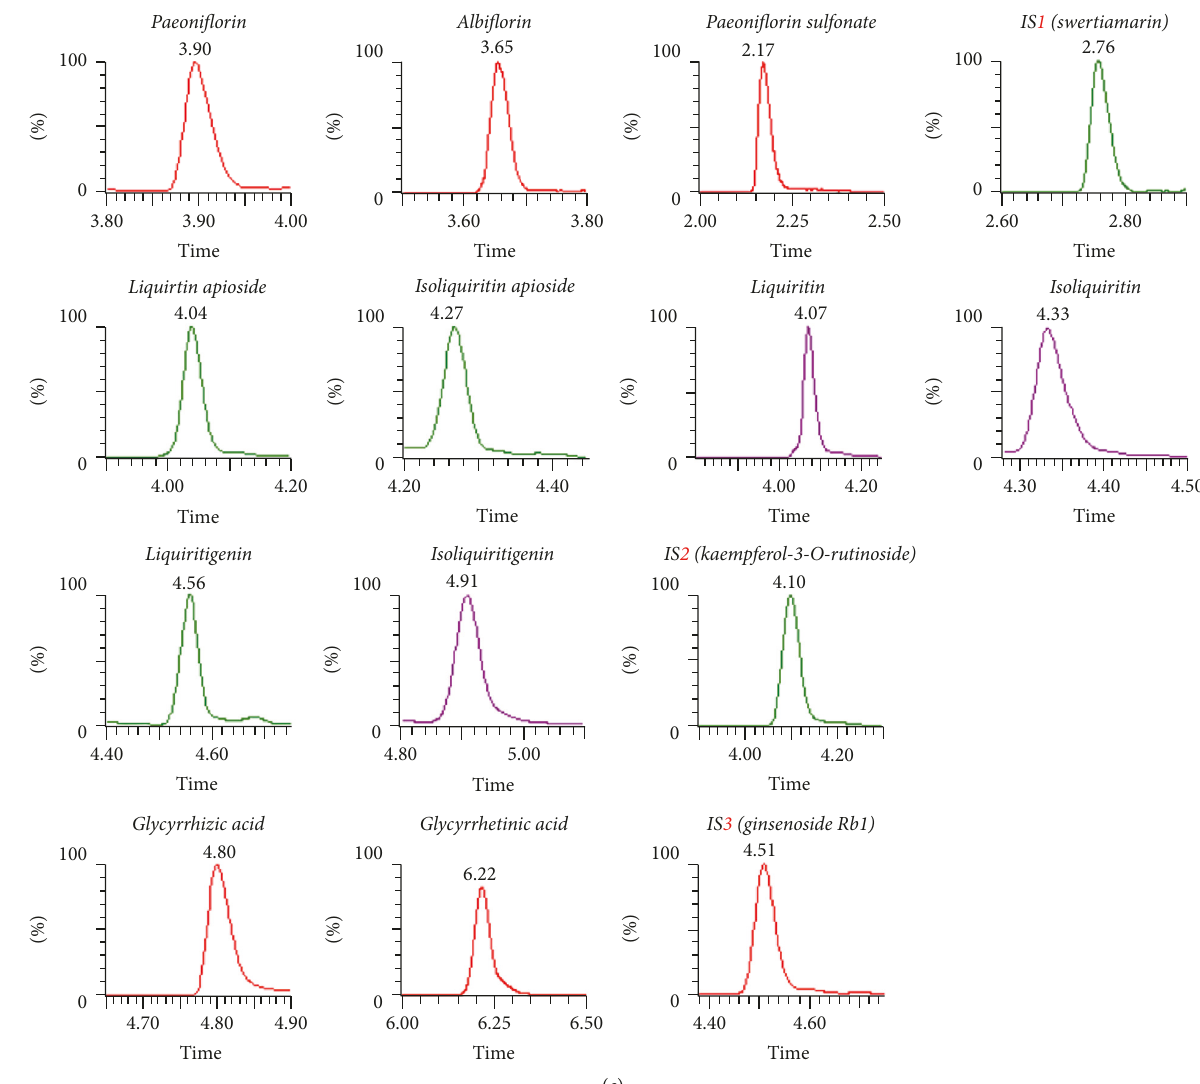
Figure 2: Typical MRM chromatograms GLGZG in rat plasma samples. (a) Blank rat plasma. (b) Plasma spiked with standards mix and IS. (c) Plasma sample after administration of GLGZG at 0.5